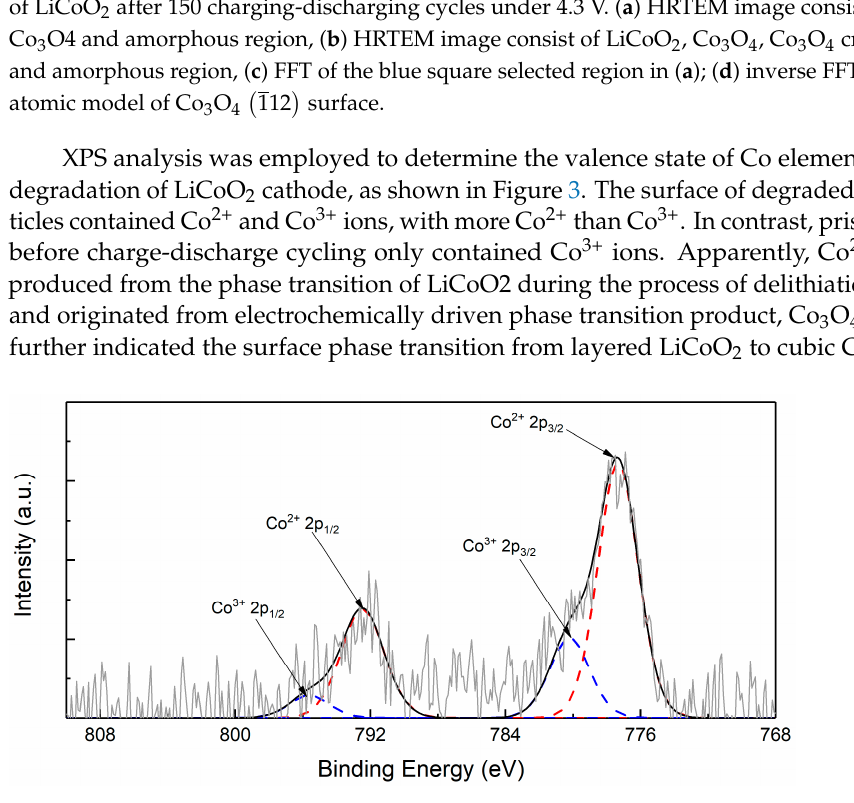
Figure 2. High resolution transmission electron microscope (HRTEM) images and structure analysis of LiCoO 2 after 150 charging-discharging cycles under 4.3 V. ( a ) HRTEM image consists of LiCoO 2 , Co 3 O4 and amorphous region, ( b ) HRTEM image consist of LiCoO 2 , Co 3 O 4 , Co 3 O 4 crystal nucleus and amorphous region, ( c ) FFT of the blue square selected region in ( a ); ( d ) inverse FFT of ( c ); ( e ) the atomic model of Co 3 O 4 (1(cid:3364)12) surface.